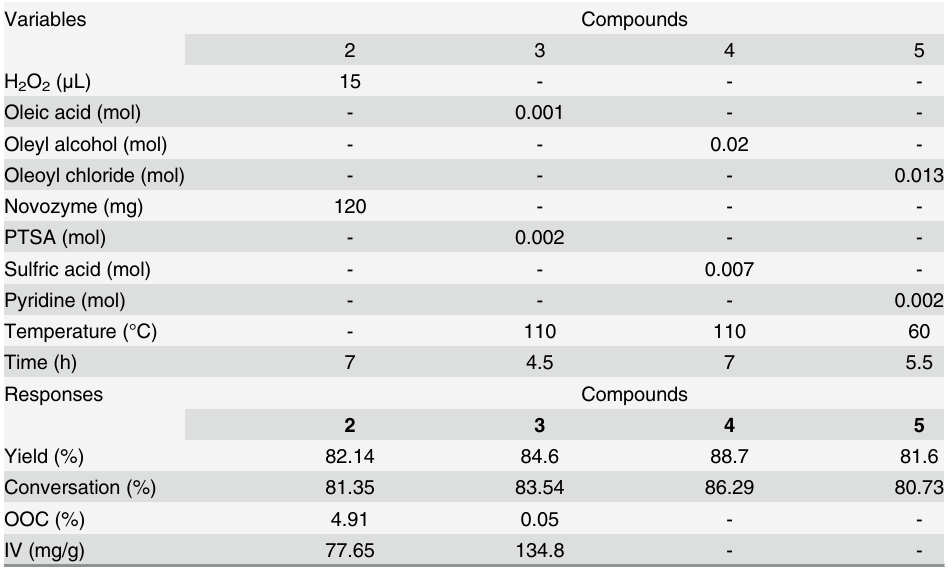
Table 1. Variables and responses of synthesis